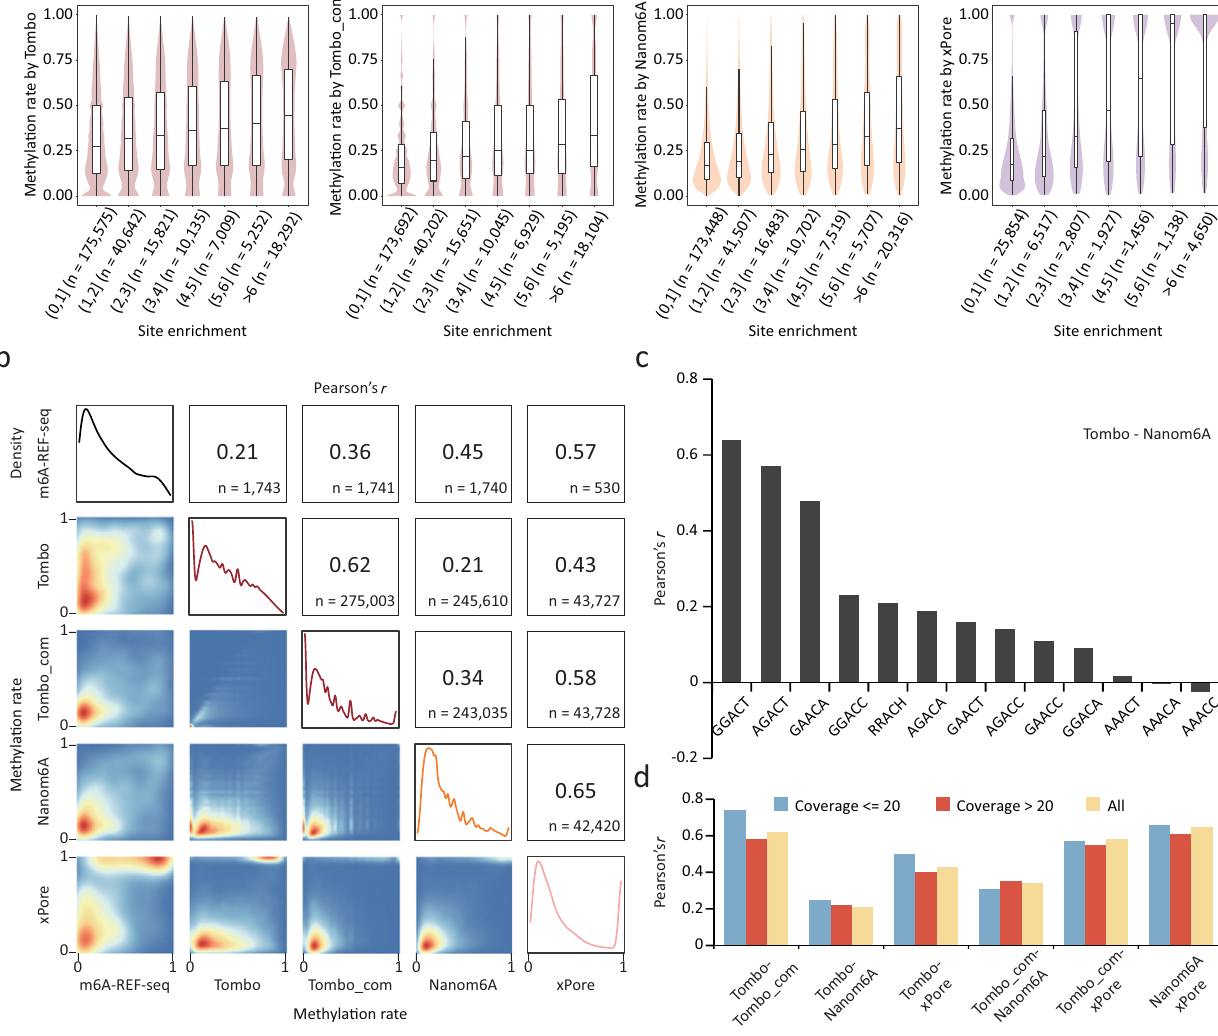
coef fi cientsandthenumberofsitesforeachpairedcomparisonareindicatedatthe top-right, with 2D-density plots of the methylation rates at the lower-left. The four densityplotsonthediagonalshowthedistributionofmethylationratesinthem6A- REF-seq results and those of each tool. c Correlation coef fi cients of methylation rates derived from Tombo and that from Nanom6A. m6A sites in different motifs are separately calculated. d Correlation coef fi cients of methylation rates derived from paired tools. m6A sites with different sequencing coverage are separately